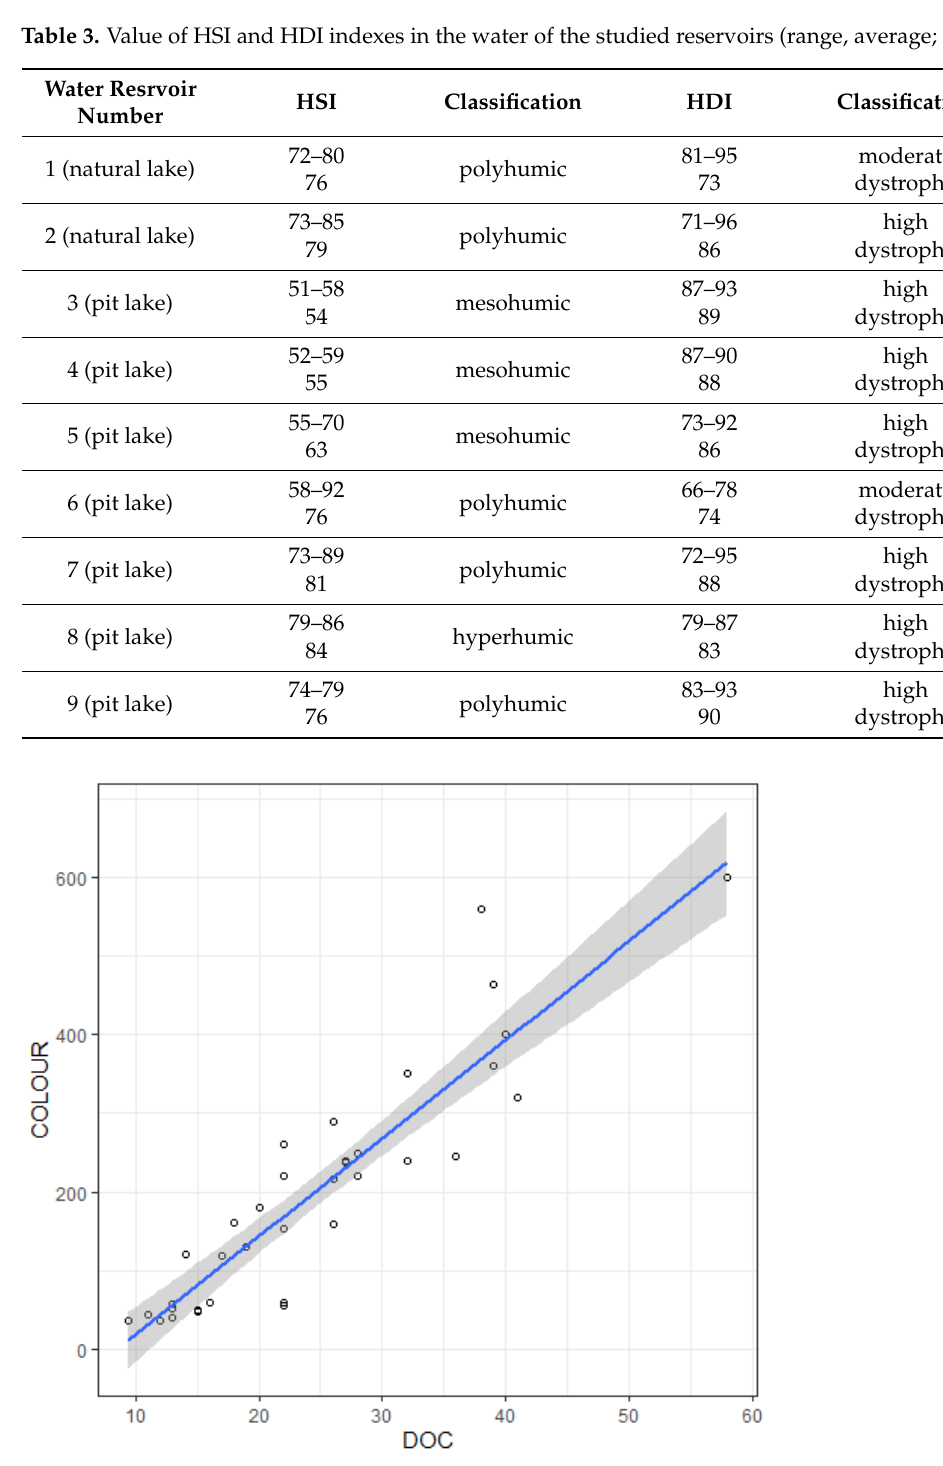
Figure 9. The correlation between DOC/colour in the water of the studied reservoirs (rs = 0.92, p < 0.01).